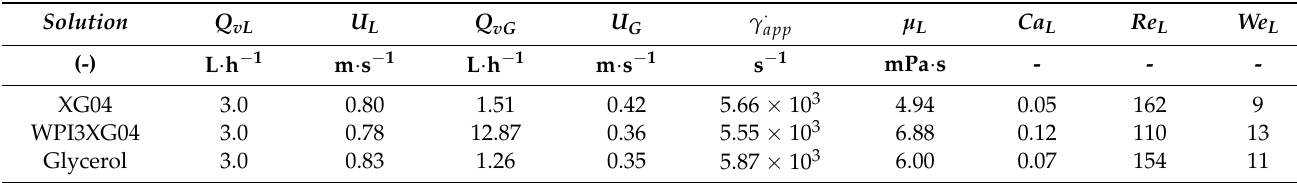
Table 5. Hydrodynamic parameters of the two-phase flow in the expansion channel of the microfluidic device CX-E-600 for the XG04, WPI3XG04 and glycerol solutions at Q vL = 3 L · h − 1 − Q mG = 5 g · h − 1 . Solution